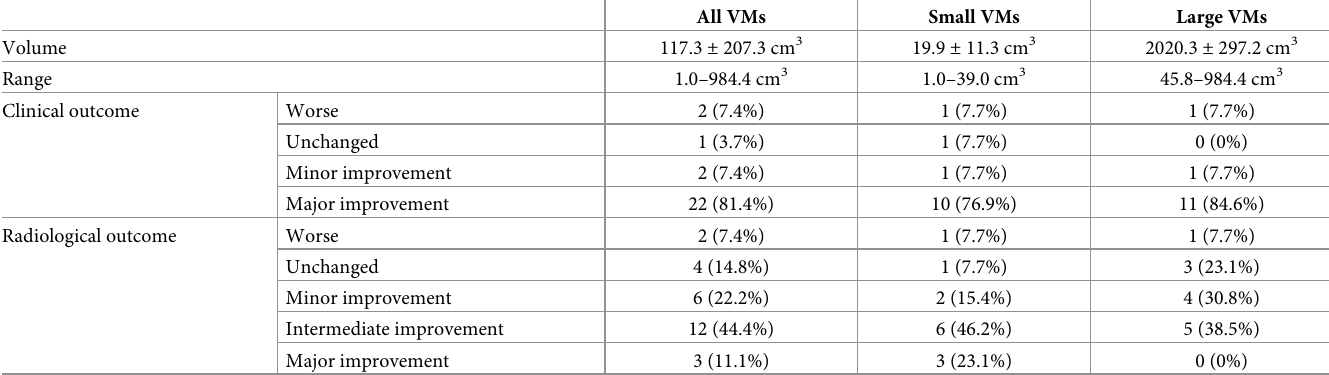
Table 2. Clinical and radiological outcome.